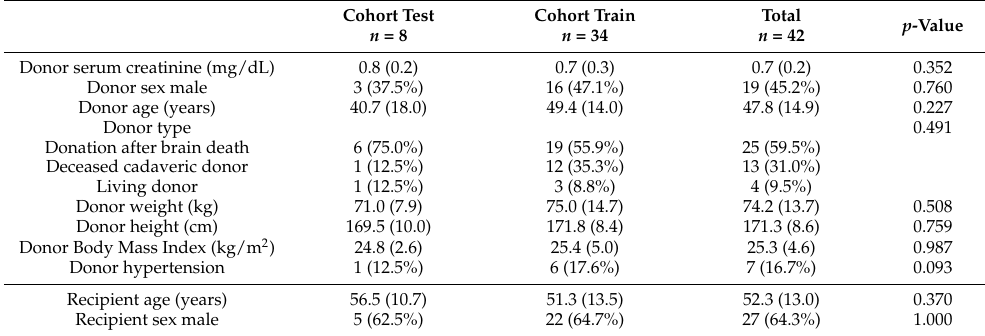
Table 2. Training and test dataset characteristics, according to the median one-year